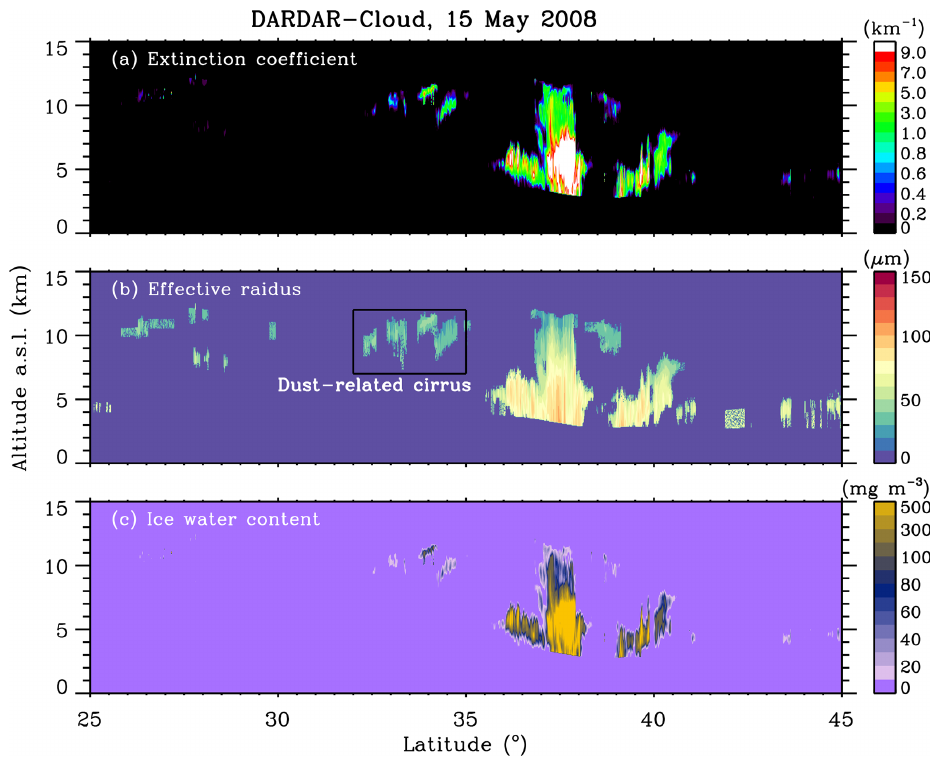
Figure 4. Altitude–orbit cross section of the (a) cloud extinction coefficient, (b) cloud particle effective radius, and (c) ice water content from the DARDAR-Cloud product on 15 May 2008. The footprint of the satellite is the same as shown in Fig. 2.